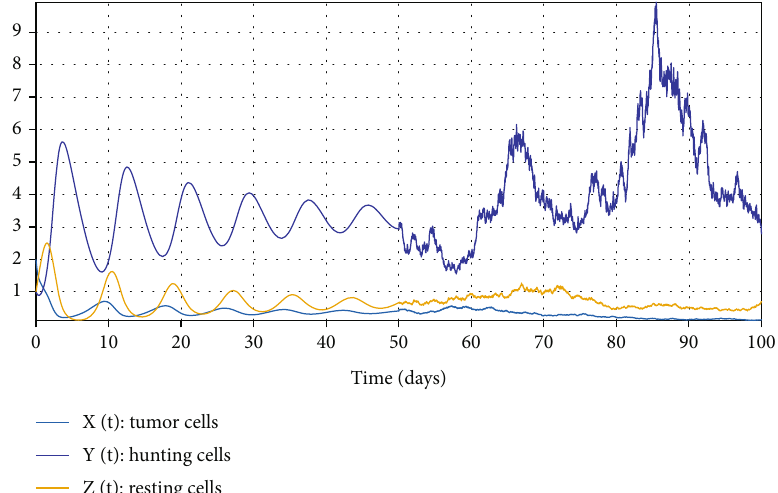
Figure 6: Time series trajectories of piecewise systems (10) and (11) for c = 1 : 6 , K = 0 : 2 : 0 : 21 , c 8